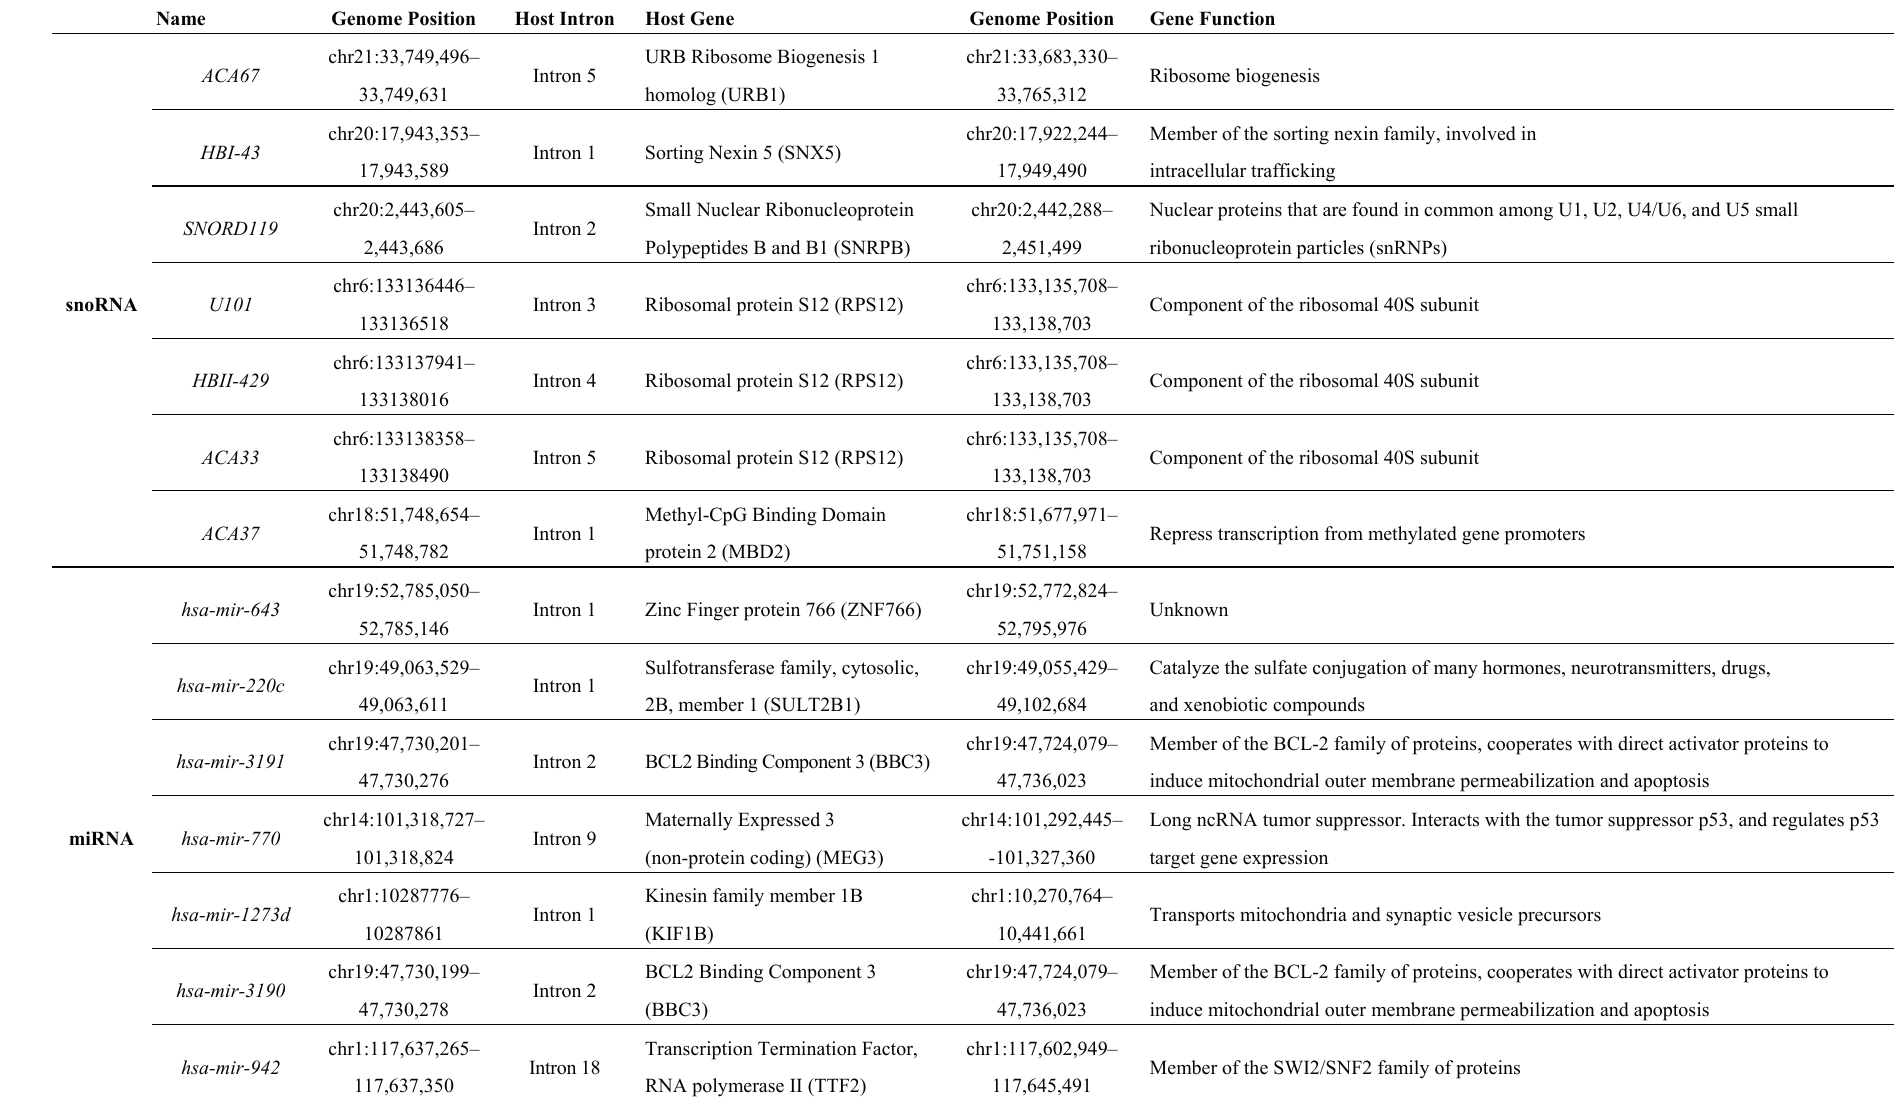
Table 4. Some examples of intronic snoRNAs and miRNAs and their host